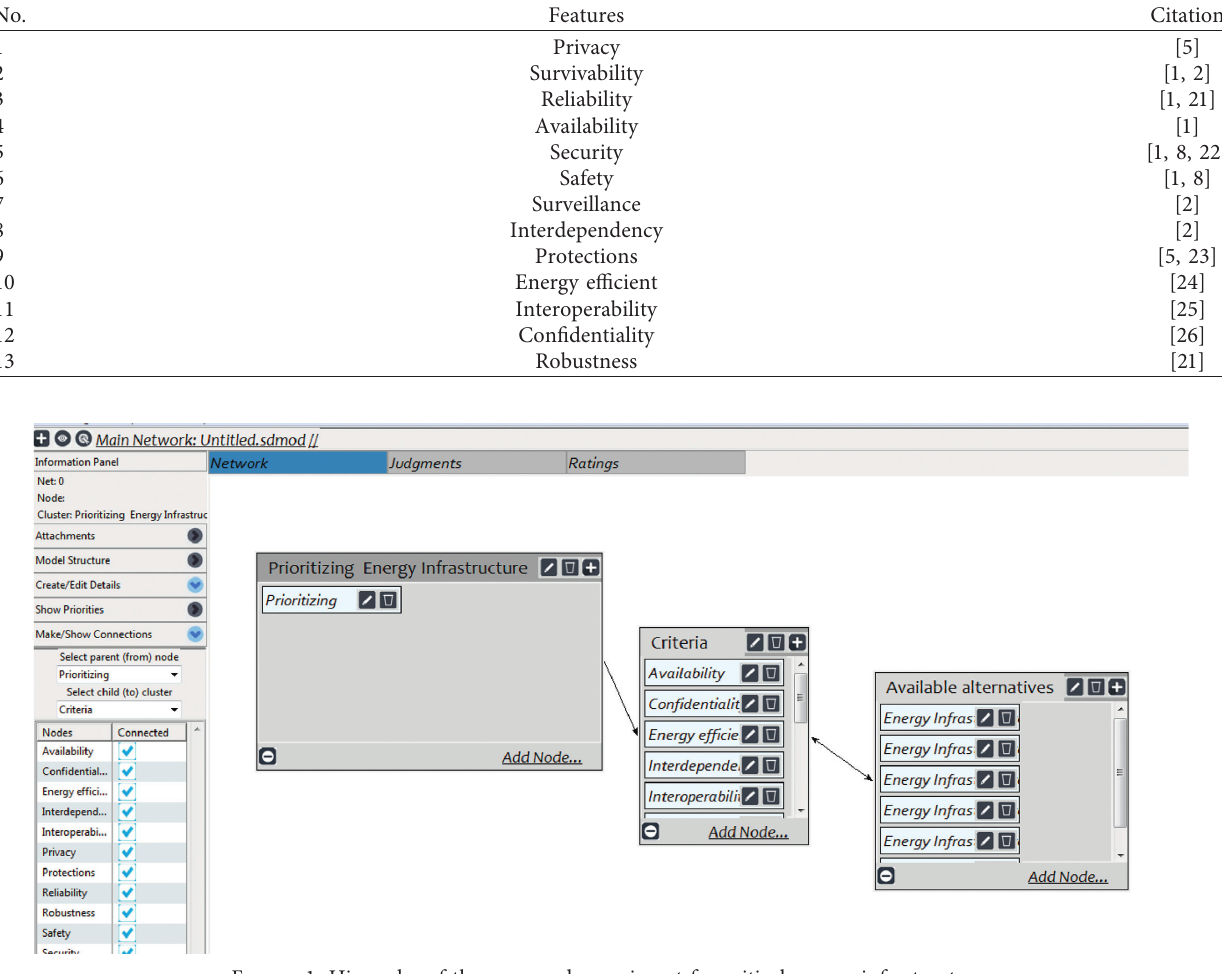
Table 1: Significant features identified from